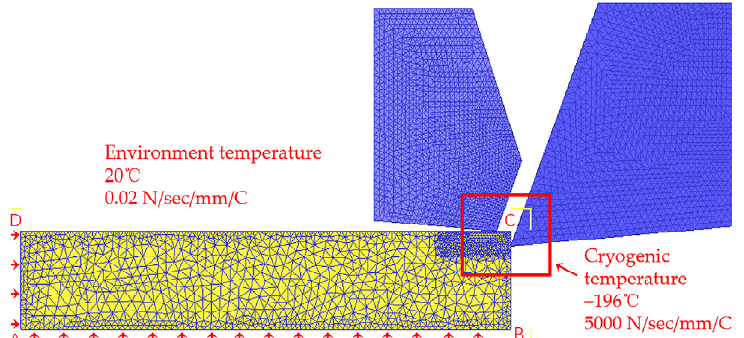
Figure 2. Structure and size of constraint block.